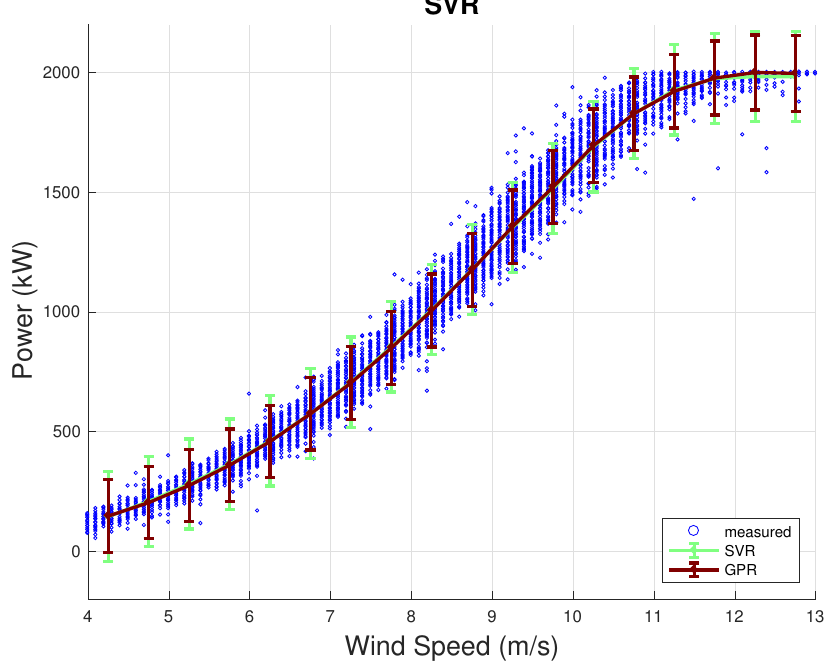
Figure 3. Measured and simulated power curve (SVR and GPR), with confidence